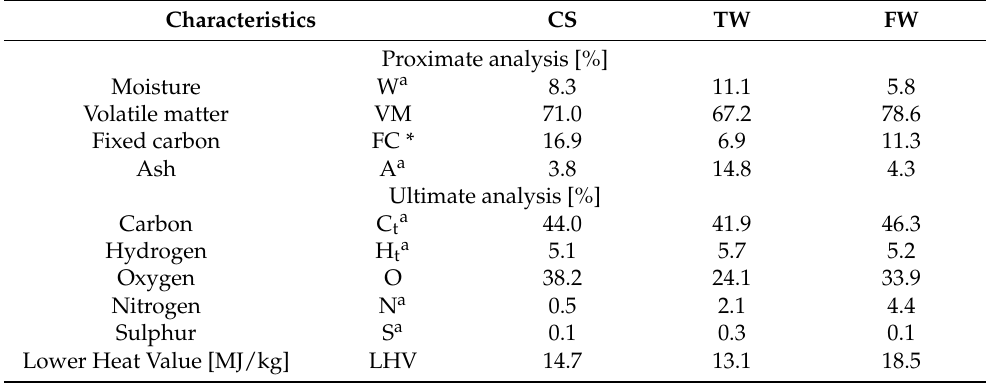
Table 2. Analytical results of air-dried waste biomass feedstock samples (CS, TW, and FW).